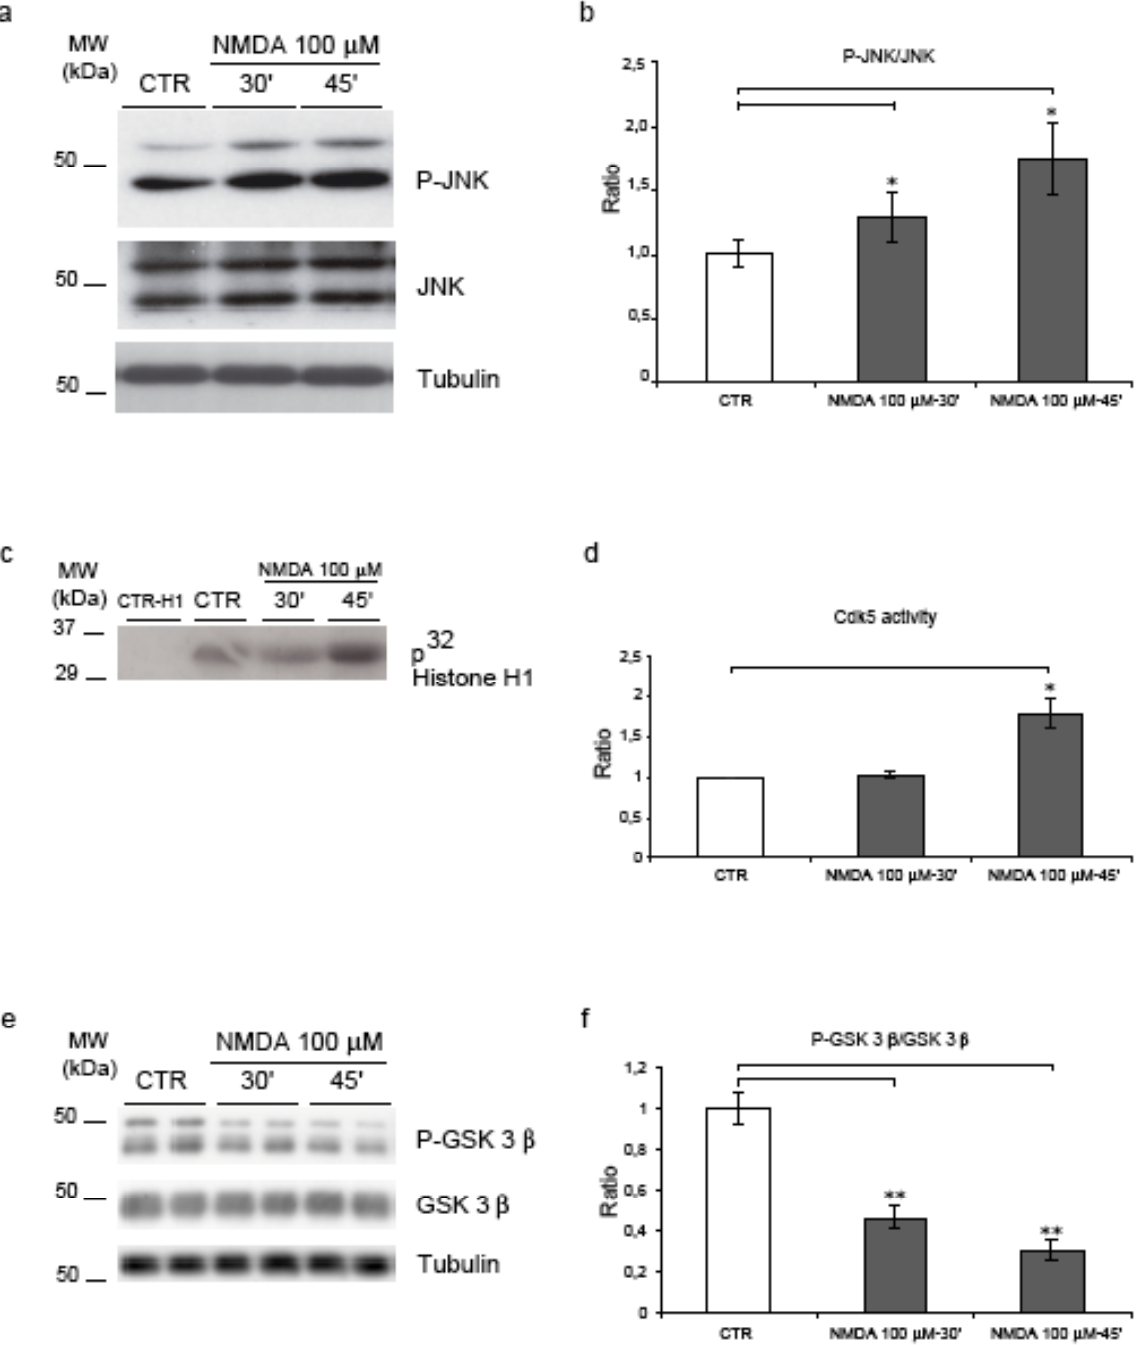
Figure 4. JNK, Cdk5 and GSK-3 β are activated following NMDA application. (a) NMDA increased JNK activity as revealed by the increment of P-JNK. (b) Quantification showed a 30% and 75% increase in JNK activity at 30’-45'. (c) Cdk5 activity assay showed an increase in enzyme activity after NMDA-45’. (d) Quantification confirmed an 80% induction of Cdk5 activity after NMDA-45’. (e) Neurons were exposed to NMDA and blotted for P-GSK-3 β and total GSK-3 β . (f) NMDA induced an increase of GSK-3 β activity at 30’ (50%) and 45’ (70%). Loading control: Tubulin. Quantifications are from six independent experiments (±S.E.M.), * p < 0.05, ** p <